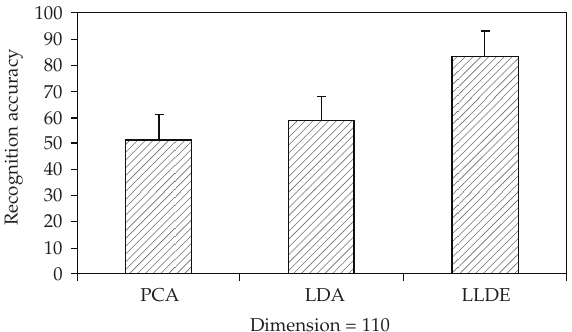
Figure 7: The average recognition rates of the PCA, LDA, and LLDE, across 10 tests (cid:2) dimension 110 (cid:3) .